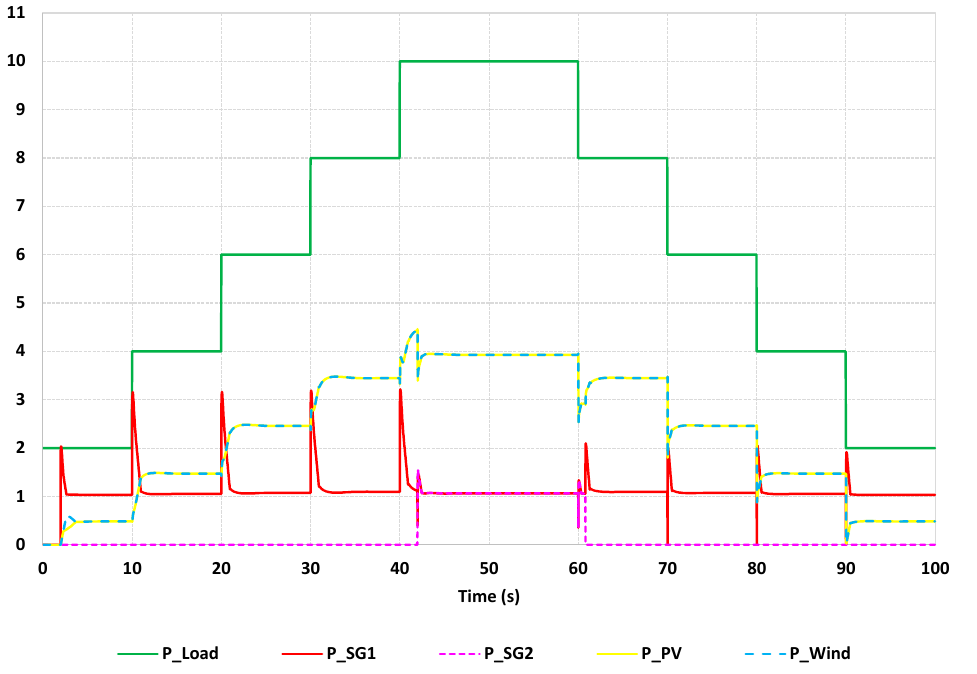
Figure 4. Scenario 1: Variable demand curve and maximum solar PV and wind generation.